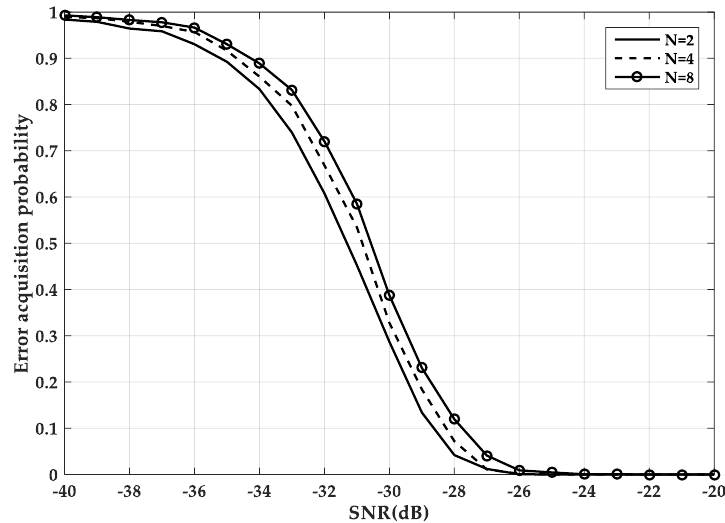
Figure 3. The false acquisition probability of three different factors.